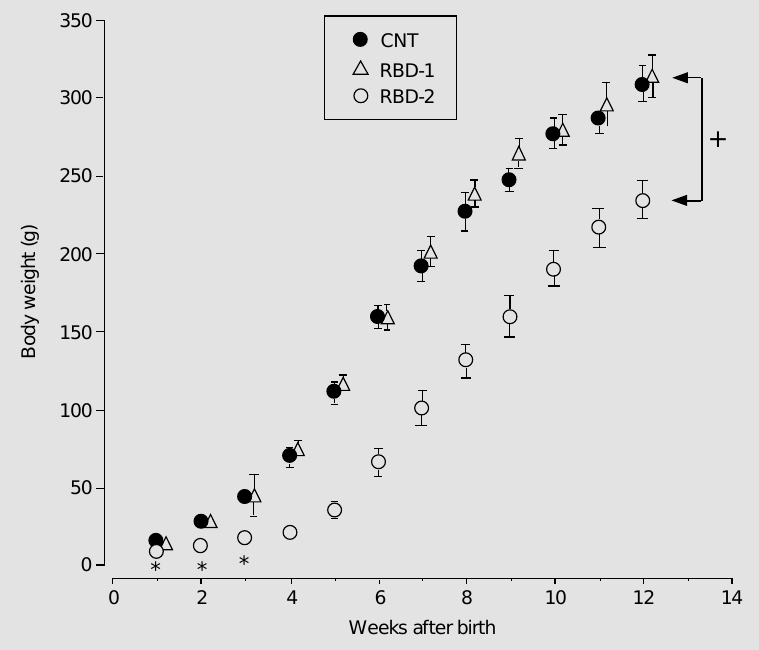
Figure 1 - Time course of body weight of offspring born to mothers receiving the regional basic diet (RBD) during pregnancy (RBD-1) or during nursing (RBD-2) and of those born to dams fed a standard balanced diet during pregnancy and nursing (CNT). Vertical bars indicate the SEM (N = 9 rats per group). In all groups, body weight was determined weekly from the 1st to the 12th week of age. During this period, the mean body weight of RBD-1 rats was similar to that of CNT rats, while the mean body weight of RBD-2 rats was significantly ( + P<0.001, two-way ANOVA) lower than that of CNT rats. *P<0.01 compared to CNT (unpaired Student t